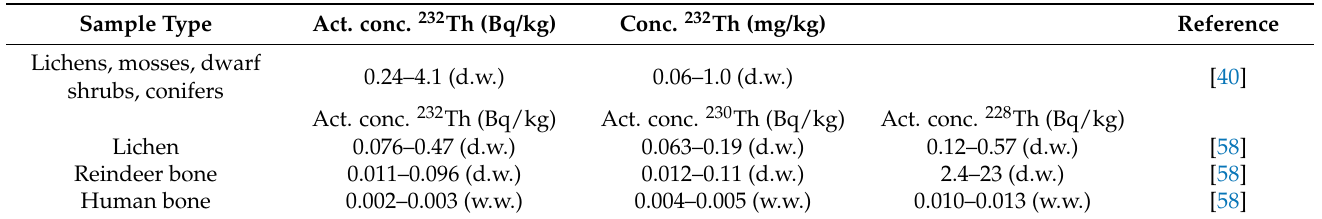
Table 5. Concentrations of Th isotopes in the Finnish environmental and biological